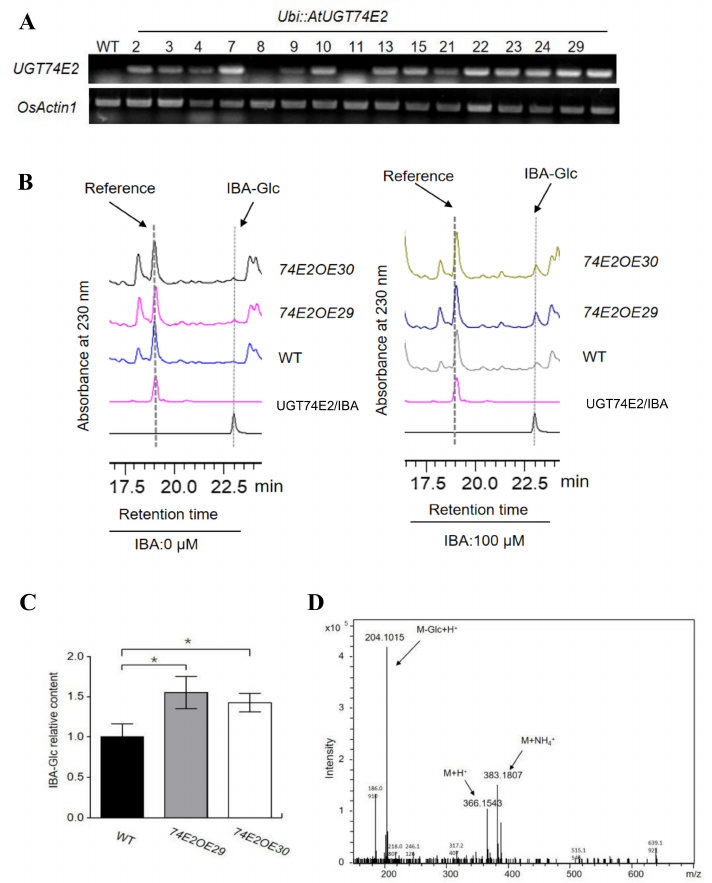
Figure 1. UGT74E2 catalyzes indole-3-butyric acid (IBA) glycosylation in rice. ( A ) RT-PCR analysis of the mRNA levels of UGT74E2 in transgenic rice plants. ( B ) HPLC profiling of IBA glucose conjugates (IBA-Glc) extracted from seven-day-old wild type (WT) and UGT74E2 -overexpressed lines after 0 µ M IBA or 100 µ M IBA treatment for 12 h. ( C ) Relative IBA-Glc contents in UGT74E2 transgenic rice plants (* p < 0.05). ( D ) LC-MS confirmation of IBA-glucose ester under positive ion